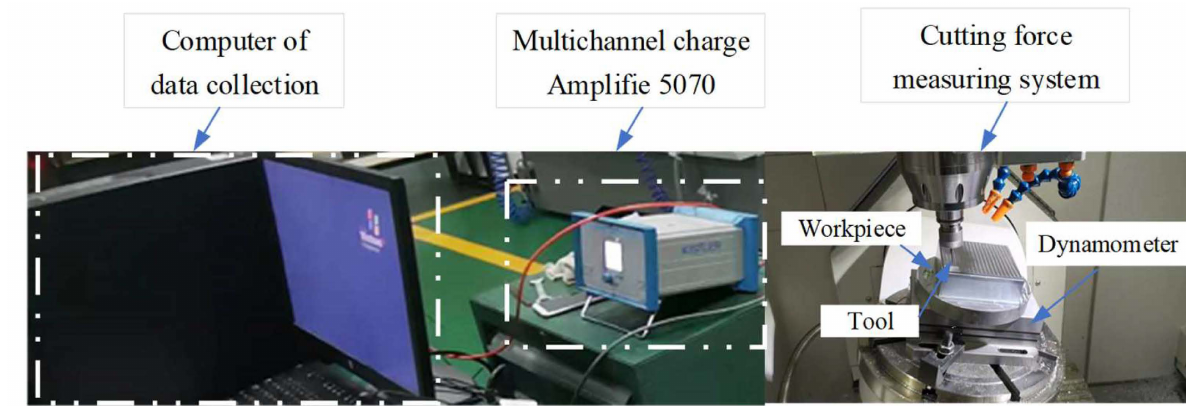
Figure 2. Principle of milling force measurement.